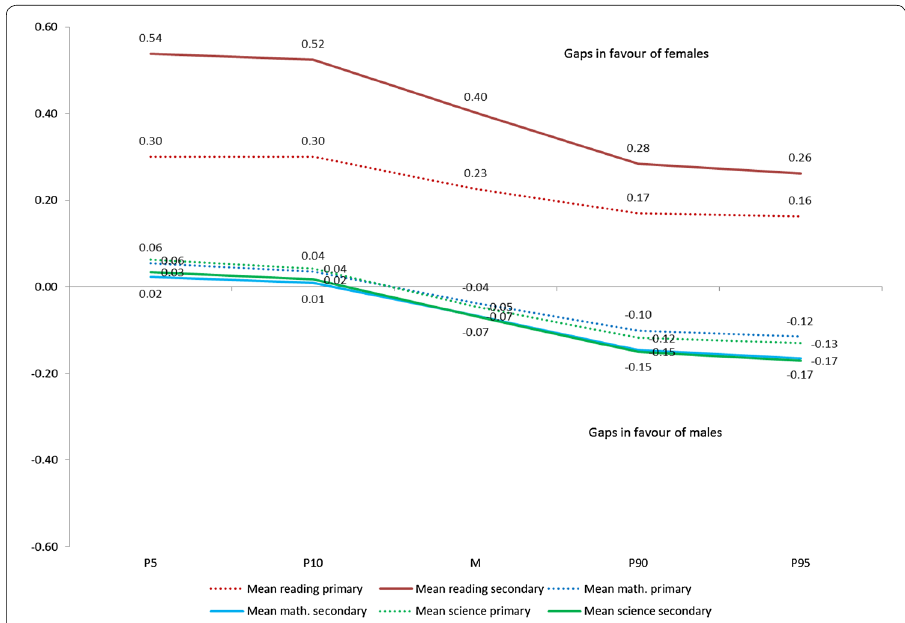
Fig. 1 Gender effect sizes in mean and extreme tails of the distribution in reading, math. and science. Gender effect sizes at percentiles 5, 10, 90, 95 and on the mean scores, by content area and education level. Positive values indicate higher scores for females; negative values indicate higher scores for males. Data IEA (TIMSS/ PIRLS) and OECD (PISA) surveys,